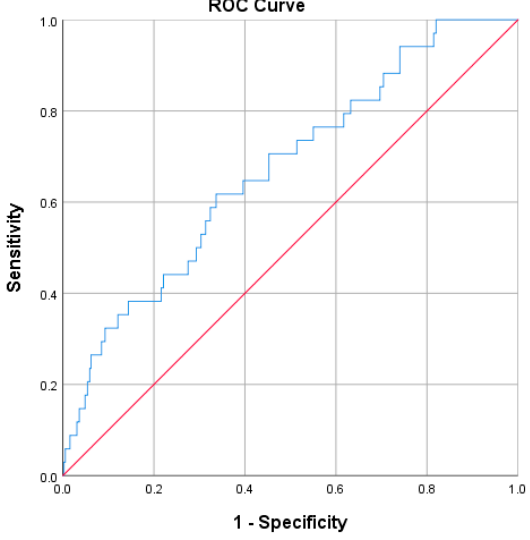
Figure 2. Receiver-operating characteristic (ROC) curve of fatty liver index (FLI) for the prediction of type 2 diabetes. C-Statistic (95% confidence interval): 0.67 (0.58–0.77), p < 0.01. The patients with FLI ≥ 60 exhibited reduced T2M-free survival (log-rank = 15.49, p < 0.001; Figure 3).